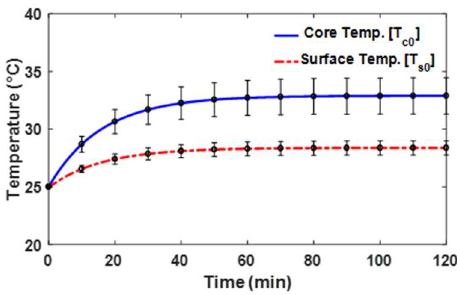
Figure 7. Uncertainty propagation in the lumped thermal models of the Li-ion battery cell at the normal operating mode, (mean value of temperatures and the variance at a few particular time intervals).